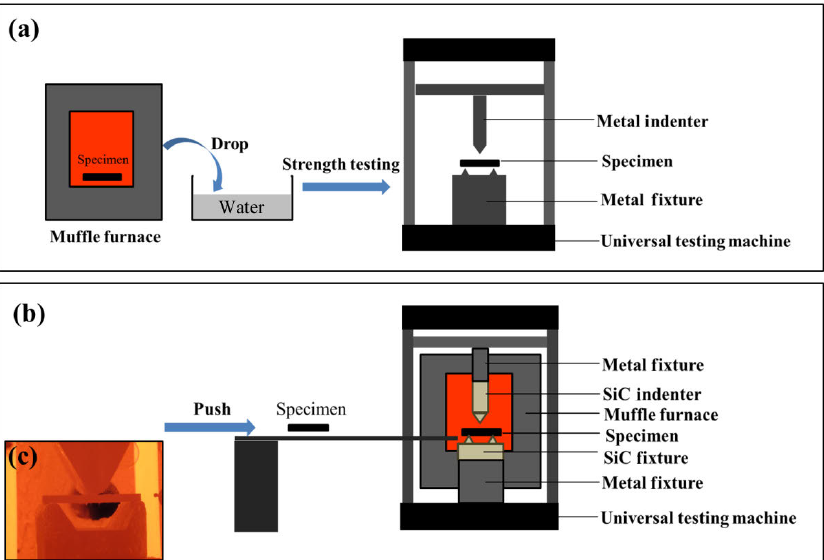
Fig. 2 Diagrammatic sketches of (a) the rapid cooling thermal shock behavior testing by traditional water quenching method, (b) the rapid heating thermal shock behavior testing by a self-assembled in situ testing method, and (c) photo of the in situ strength testing